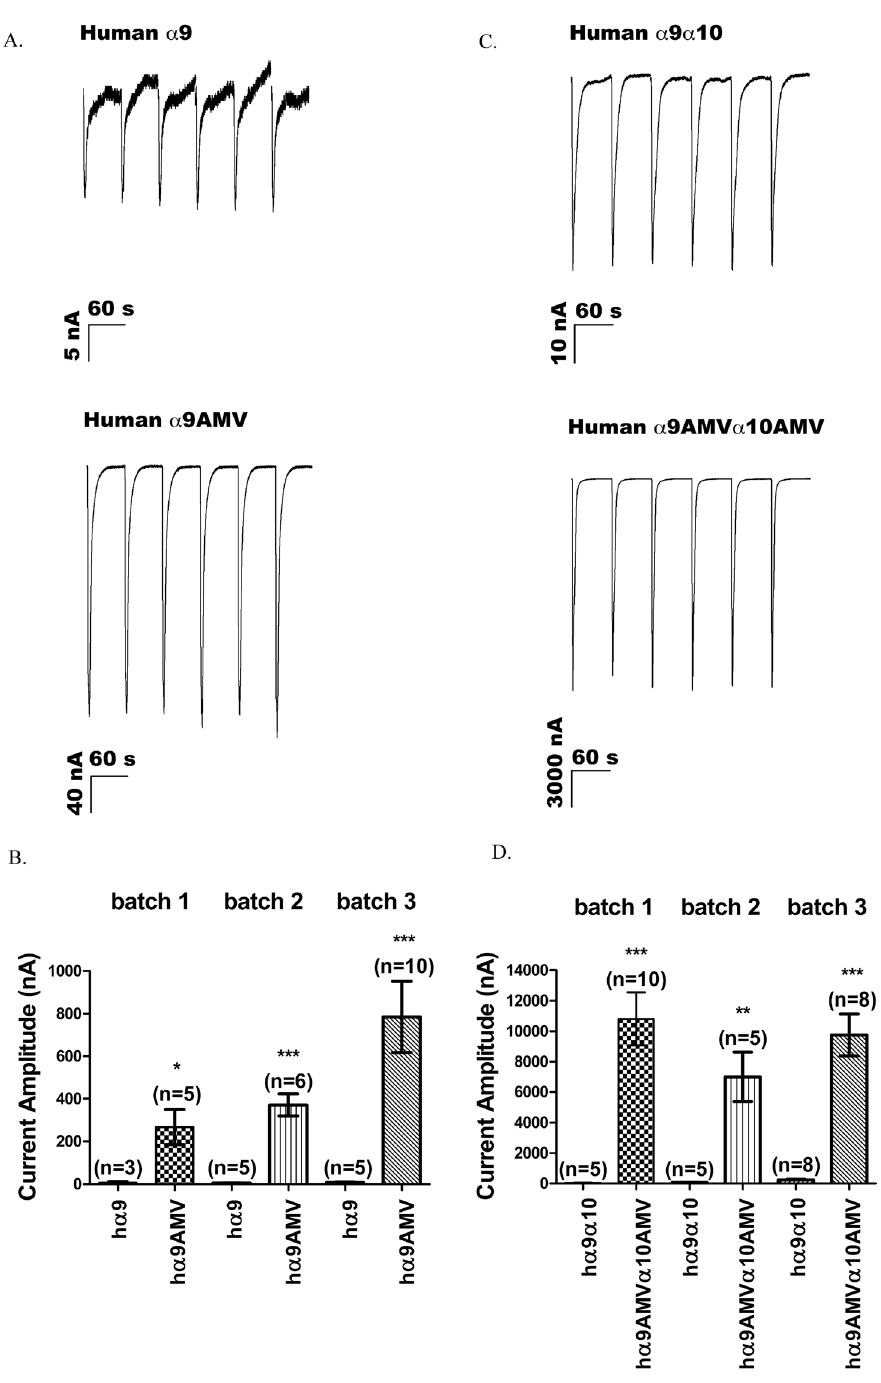
Figure 5. AMV improves the level of functional expression of a 9-containing nAChRs. (A) Representative traces and (B) comparisons of the levels of functional expression of homomeric human a 9 receptors encoded by cRNA without (A, top) and with (A, bottom) AMV. The results are from three different batches of oocytes, each isolated from a different frog and recorded on 3 rd day after injection, are presented. (C and D) Comparison of the level of expression of heteromeric receptors. Recordings were conducted on the second day after injection. Values for mean current amplitude are shown in Tables 3 and 4. *p , 0.05; **p , 0.01. Error bars indicate SEM. doi:10.1371/journal.pone.0064655.g005 (uORF) [69], [71]. Due to their importance, the UTR regions are UTRs, which results in improved yields of translated proteins or frequently modified to improve translation. For example, it improved functional expression of receptors. For example, the became a common practice to include 5 9 - and 3 9 - UTRs of 5 9 UTR of tobacco mosaic virus enhances the translation of Xenopus b -globin into expression vectors to flank the gene-coding chloramphenicol acetyltransferase and b -glucuronidase in tobacco mesophyll protoplasts, E. coli , and Xenopus oocytes [56], [58], [59], region [51]. UTRs of viruses have also been used to replace native